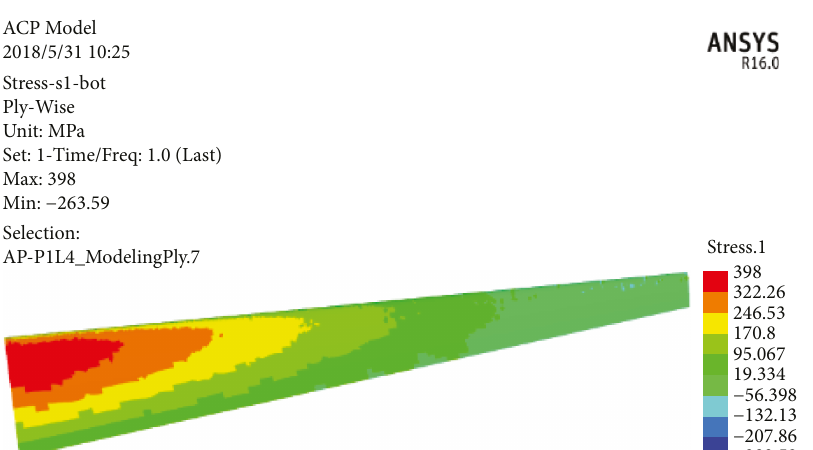
Figure 25: Stress cloud diagram of the lower wing with the layer sequence being [90/0/45/0/90]